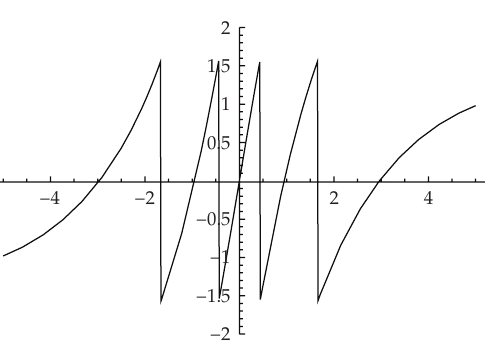
Figure 5: Graph of the arctangent function Φ 3 . 8 (cid:3) X (cid:4)